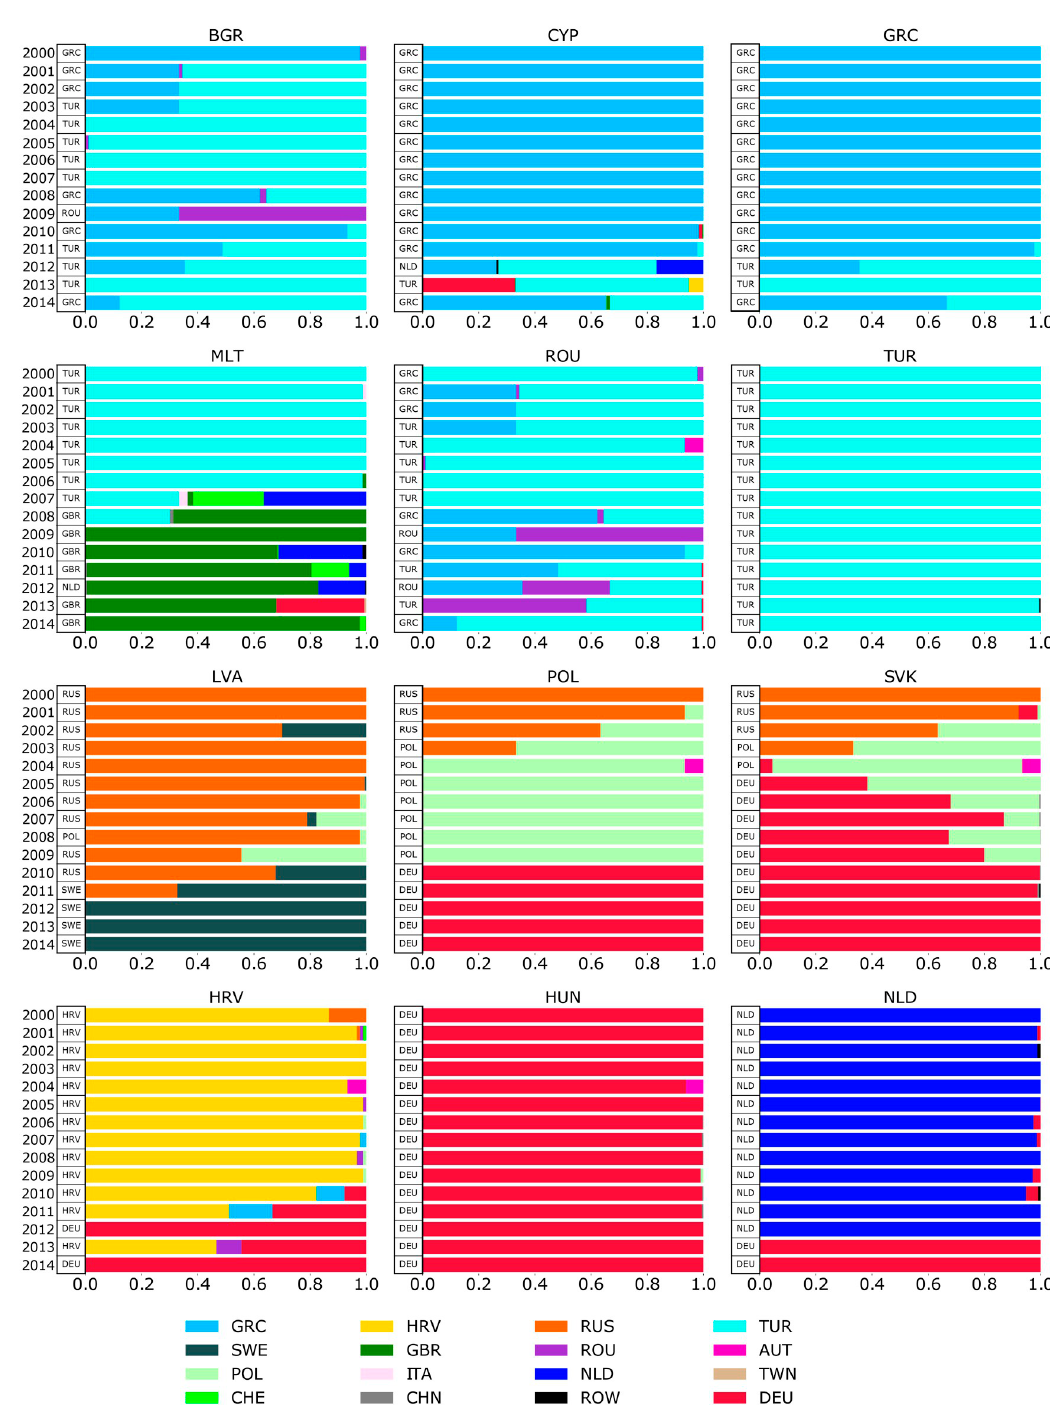
Fig 4. Fractions of algorithm calls due to the assignment of particular countries (an assignment of the majority of a given country sectors). The tables near the y-axis contain information about the assigned community in the partition with the highest